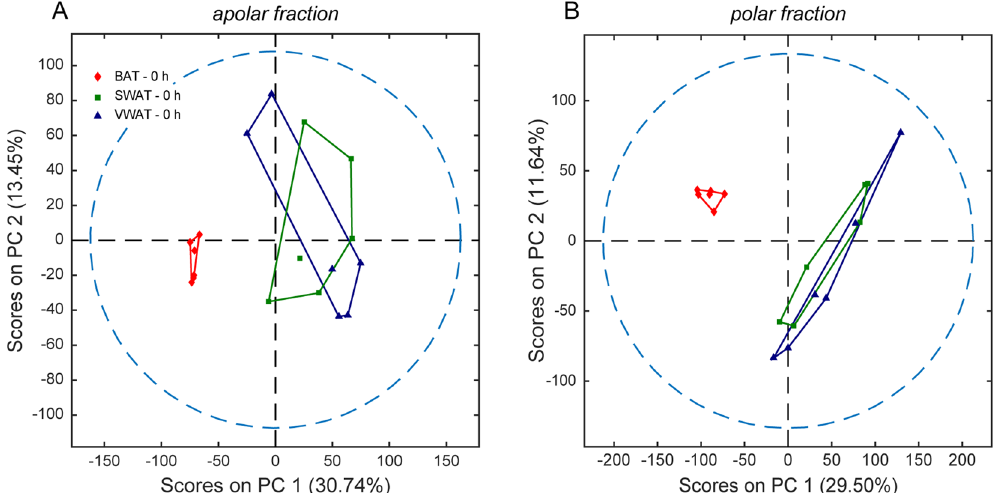
Figure 1. Metabolic differences in adipose tissues from different depots at thermoneutrality. An untargeted multilevel PCA was performed on combined HPLC-MS and MRS data acquired on BAT, SWAT and VWAT sample extracts at thermoneutrality. Score plots obtained from PCA performed on apolar ( A ) and polar ( B ) spectra of BAT, SWAT, and VWAT samples (6 replicates per tissue type) are